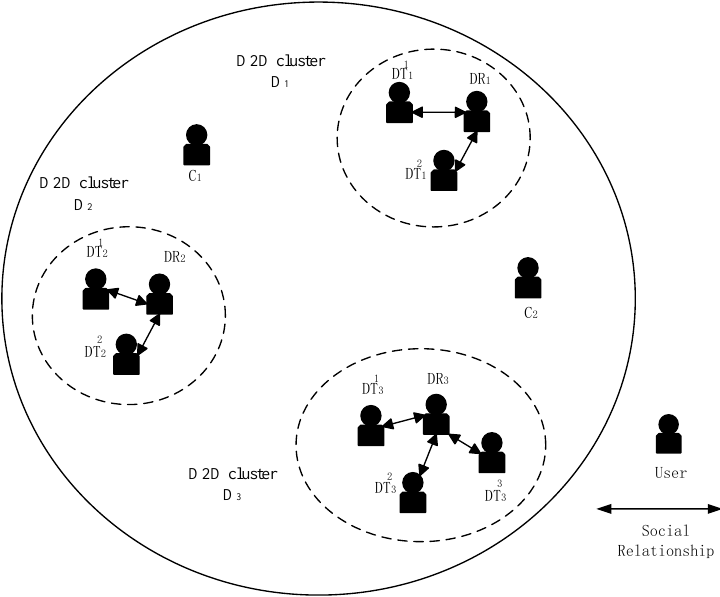
Figure 2. System model (social domain).